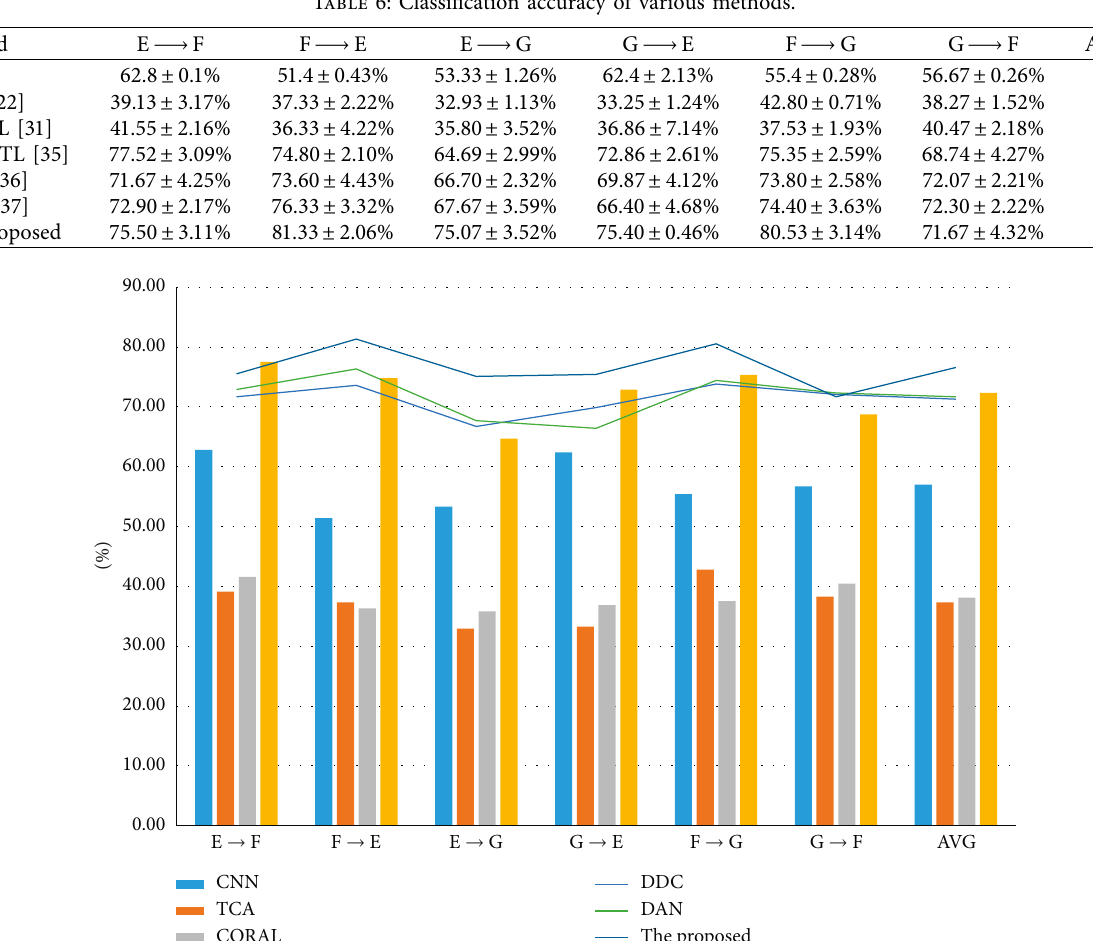
Figure 8: Classification accuracy of mentioned methods. Table 6: Classification accuracy of various methods.